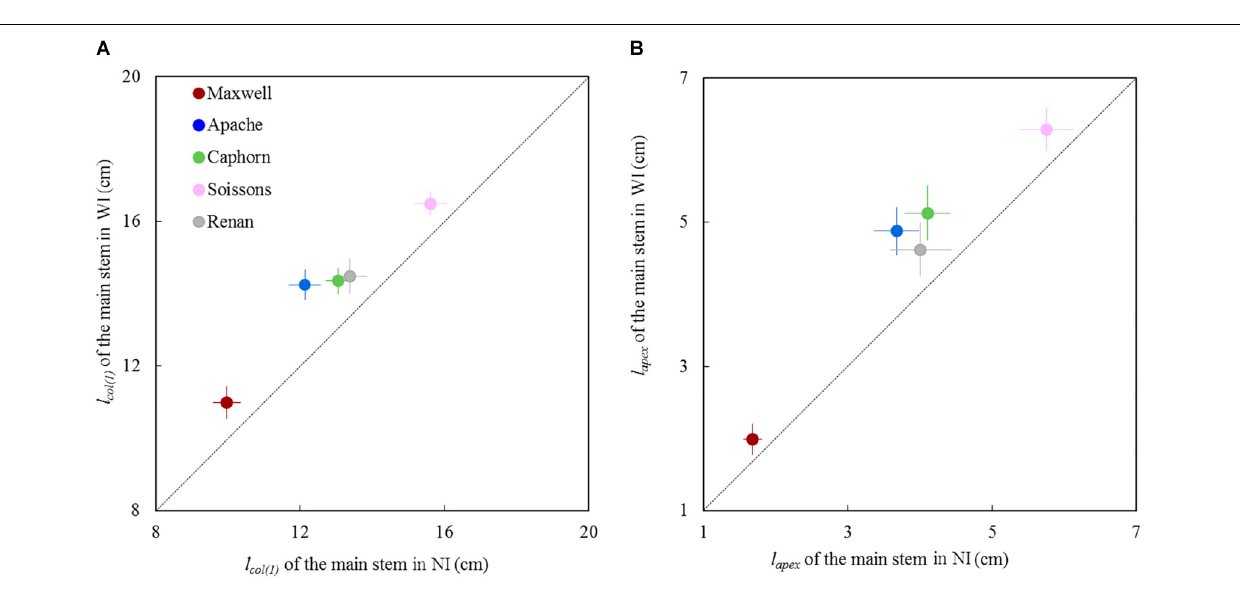
FIGURE 5 | Length of the main stem in WI treatments vs. NI treatments at the start of stem extension (870 ◦ Cd). (A) shows l col ( 1 ) , which represents the length from the base of the plant up to the highest collar and figure (B) shows l apex , the length from the base of plant to the summit of the apex. Each symbol represents the mean of values measured on 30 stems. Each color is associated with a cultivar, as indicated in the legend. Error bars represent 95% confidence intervals of mean estimates. The dotted line represents the line